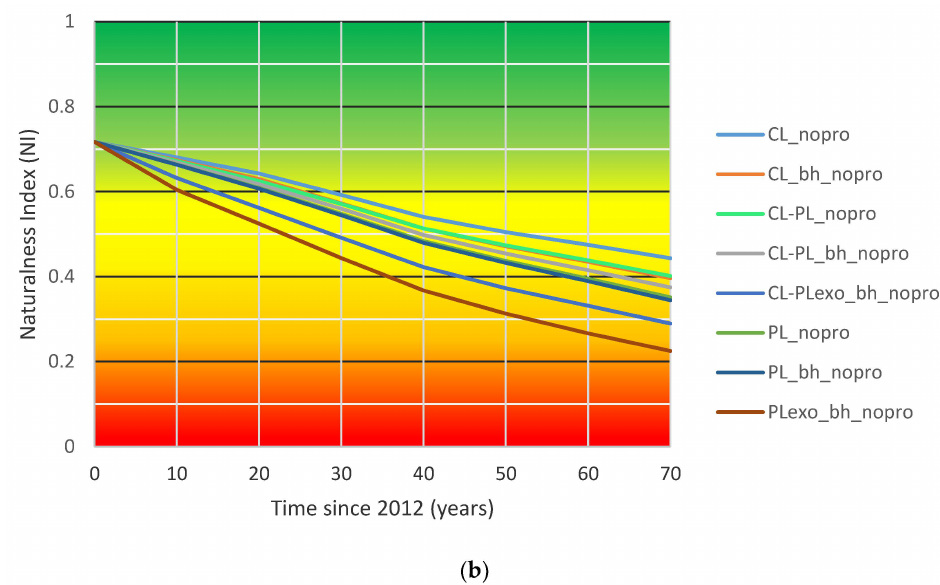
Figure 6. Results for the 3 FMU over time: ( a ) With protected areas; ( b ) without protected areas. Scenario description: CL: 100% careful logging, CL-PL: 50% careful logging and 50% plantation of indigenous species, CL-PLexo: 50% careful logging and 50% plantation of exotic species, PL: 100% plantation of indigenous species, PLexo: 100% plantation of exotic species, bh: with biomass harvest, pro: with strict protected areas, nopro: without strict protected